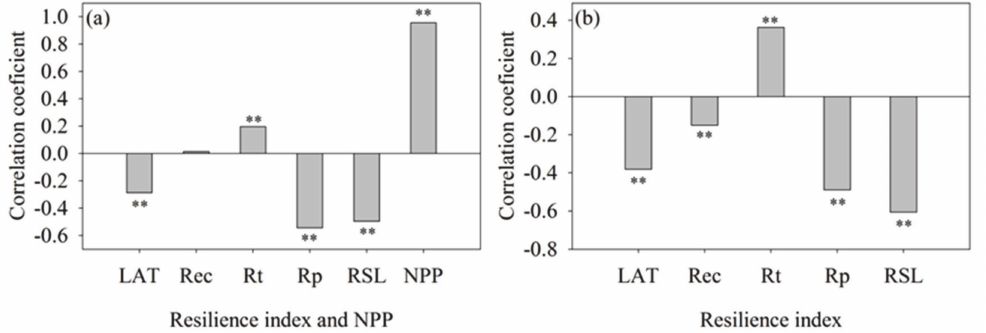
Figure 4. Correlation analysis between mean coverage, resilience index, and NPP on vegetation type scales. ( a ) Is the correlation between mean resilience index, NPP , and vegetation coverage of different vegetation types. ( b ) Is the correlation between mean NPP and resilience index of different vegetation types. ‘**’ indicates the extremely significant correlation between